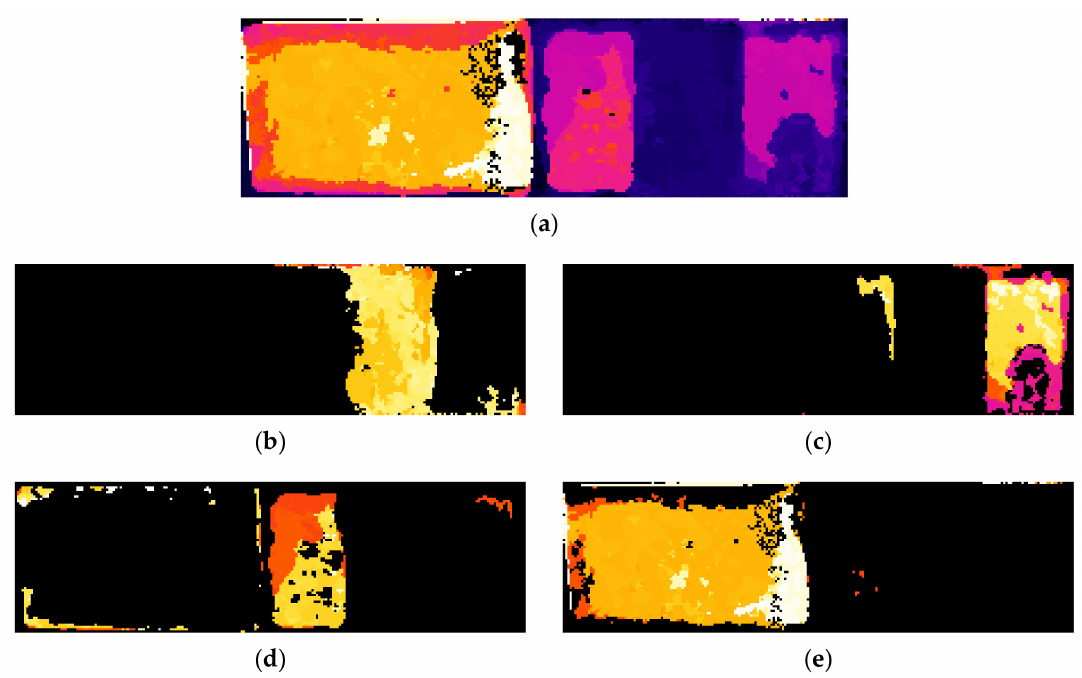
Figure 19. Thermal tomograms of specimen “slices”: ( a ) layer coordinates: 0–2 mm, ( b ) 0–0.3 mm, ( c ) 0.3–0.6 mm, ( d ) 0.6–0.9 mm, ( e ) 0.9–1.2